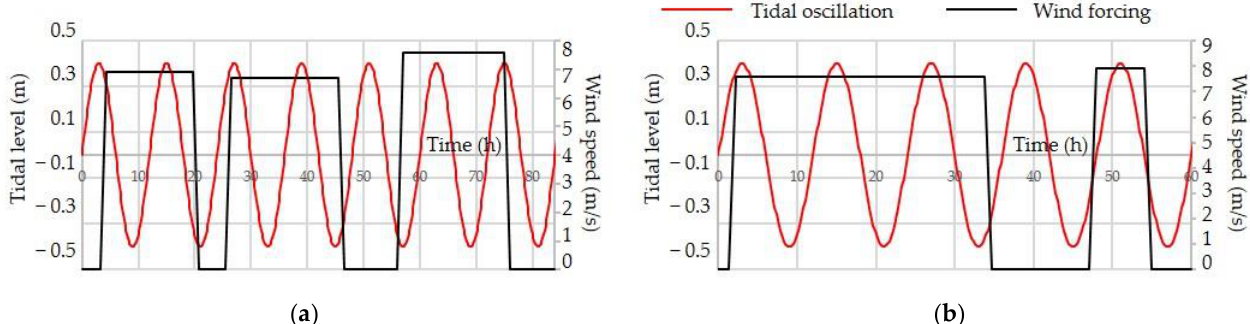
Figure 7. Wind and tidal forcings: ( a ) Bora events superimposed to tidal oscillations; ( b ) Sirocco events superimposed to tidal oscillations.